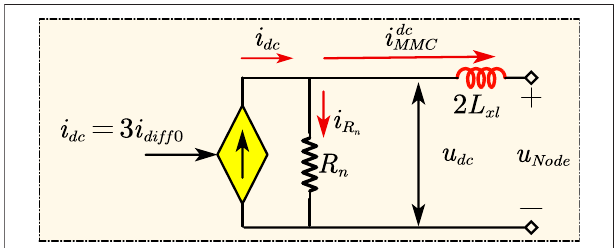
FIGURE 2 | DC interface of